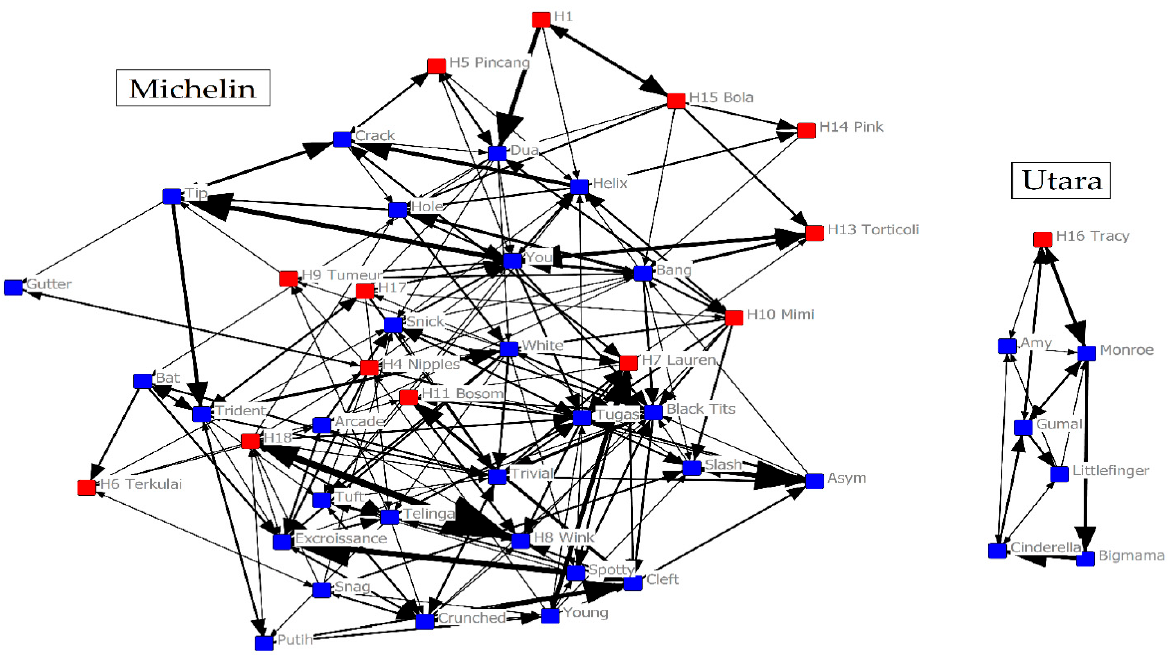
Figure 3. Grooming network of adult females in Michelin ( left ) and Utara ( right ) group at the Ubud Monkey Forest (early 2020). Color of nodes refers to the fertility status (red for sterilized females, blue for intact females). The arrows show the direction of the interactions and the tie size is scaled based on the strength of the relationship.